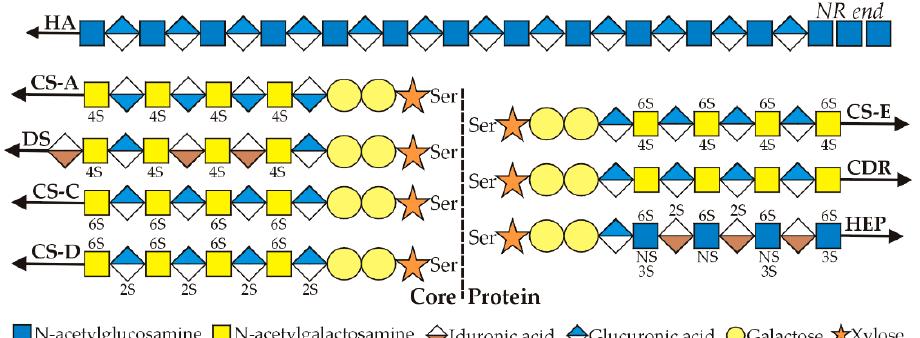
Figure 1. Glycosaminoglycan diversity. The schematic representation of glycosaminoglycans (GAG) structures shows that heparin (Hep), dermatan sulfate (DS), chondroitin (CDR), chondroitin sulfates A (CS-A), C (CS-C), D (CS-D), and E (CS-E), but not HA, are synthesized onto core proteins (dashed line), which can be membrane-bound or soluble, via a common linker sequence (Galactose-Galactose-Xylose; two circles-star) attached to Ser. All GAGs are made as linear polymers with repeating disaccharide units containing either N-acetylglucosamine (GlcNAc, blue square) or N-acetylgalactosamine (GalNAc, yellow square) and either glucuronic acid (GlcU, blue diamond) or iduronic acid (IdU, brown diamond). Arrows denote the polymer growing end, to which new sugars are added. Sulfation occurs during biosynthesis and di ff erent cell types can create di ff erent negative charge patterns (unique molecular signatures) that are specifically recognized by other soluble or membrane proteins (e.g., Hyaluronic Acid Receptor for Endocytosis (HARE)). GAGs built on a core protein are attached at their reducing end, and new sugars are added at the nonreducing end. In contrast, HA is not attached to or built onto a core protein. Rather, HA synthesis is initiated de novo and extended by HA synthase until the UDP-HA chain is released, at which point it cannot be rebound and extended further [2]. Additionally di ff erent is that HA synthesis occurs at the reducing end, which is still attached to UDP. Thus, the first sugars assembled remain at the nonreducing end (NR end) and the linkages in this unique region are chitin [GlcNAc( β 1,4) n ] rather than HA. HA synthase initiates HA disaccharide synthesis only after first assembling a chitin-UDP (UDP-GlcNAc 3-4 ) primer for starting HA synthesis [2]. The primer then remains as a chitin cap at the NR end